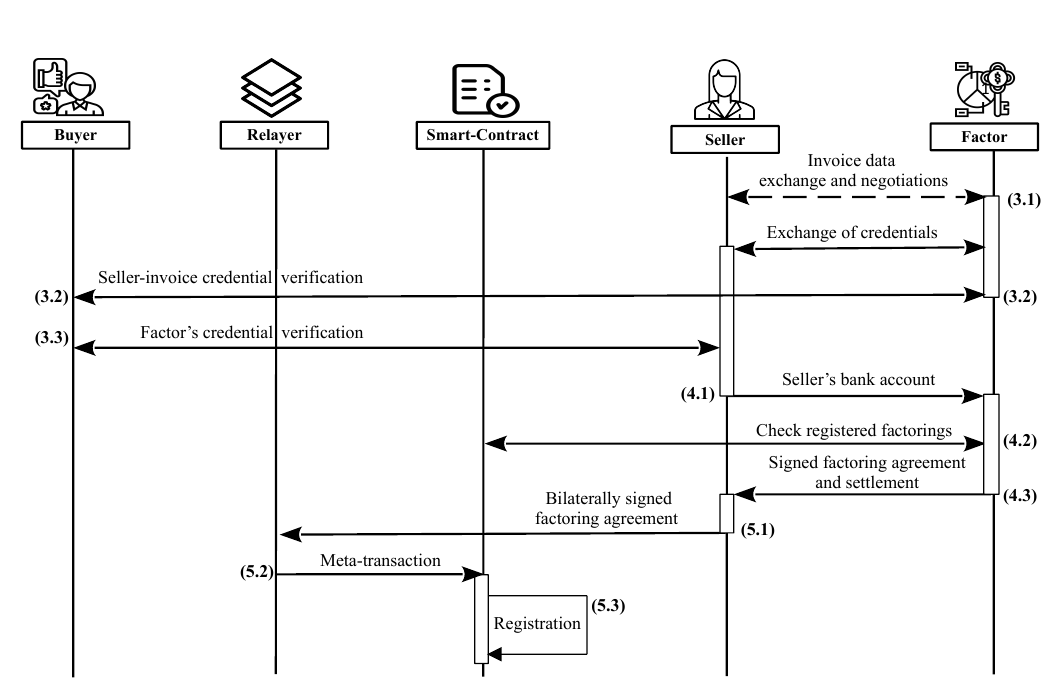
Figure 4. The factoring